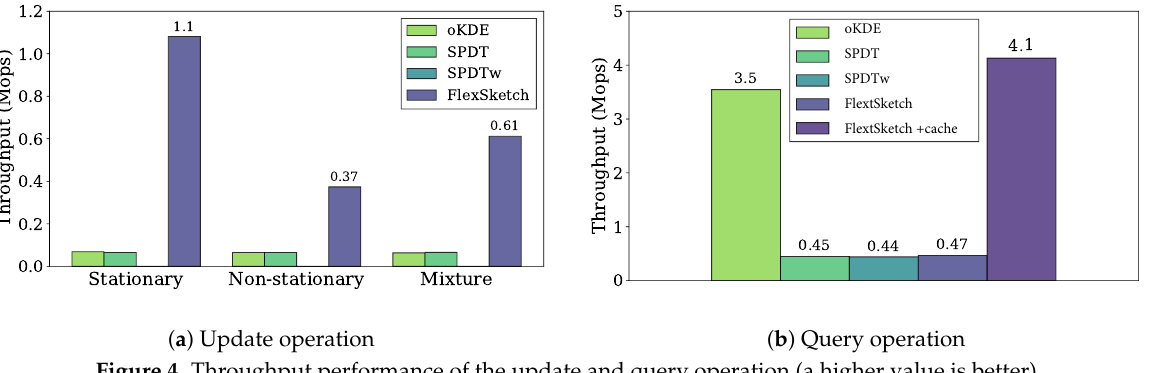
Figure 4. Throughput performance of the update and query operation (a higher value is better).